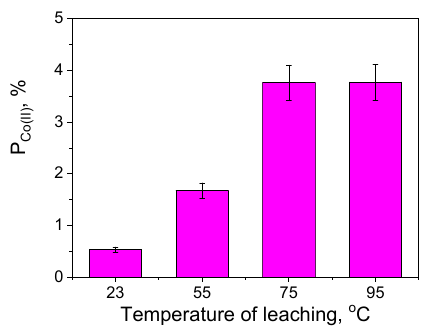
Figure 5. The efficiency of Co(II) precipitation from solutions after leaching with 0.5 M H 2 SO 4 at various temperatures.